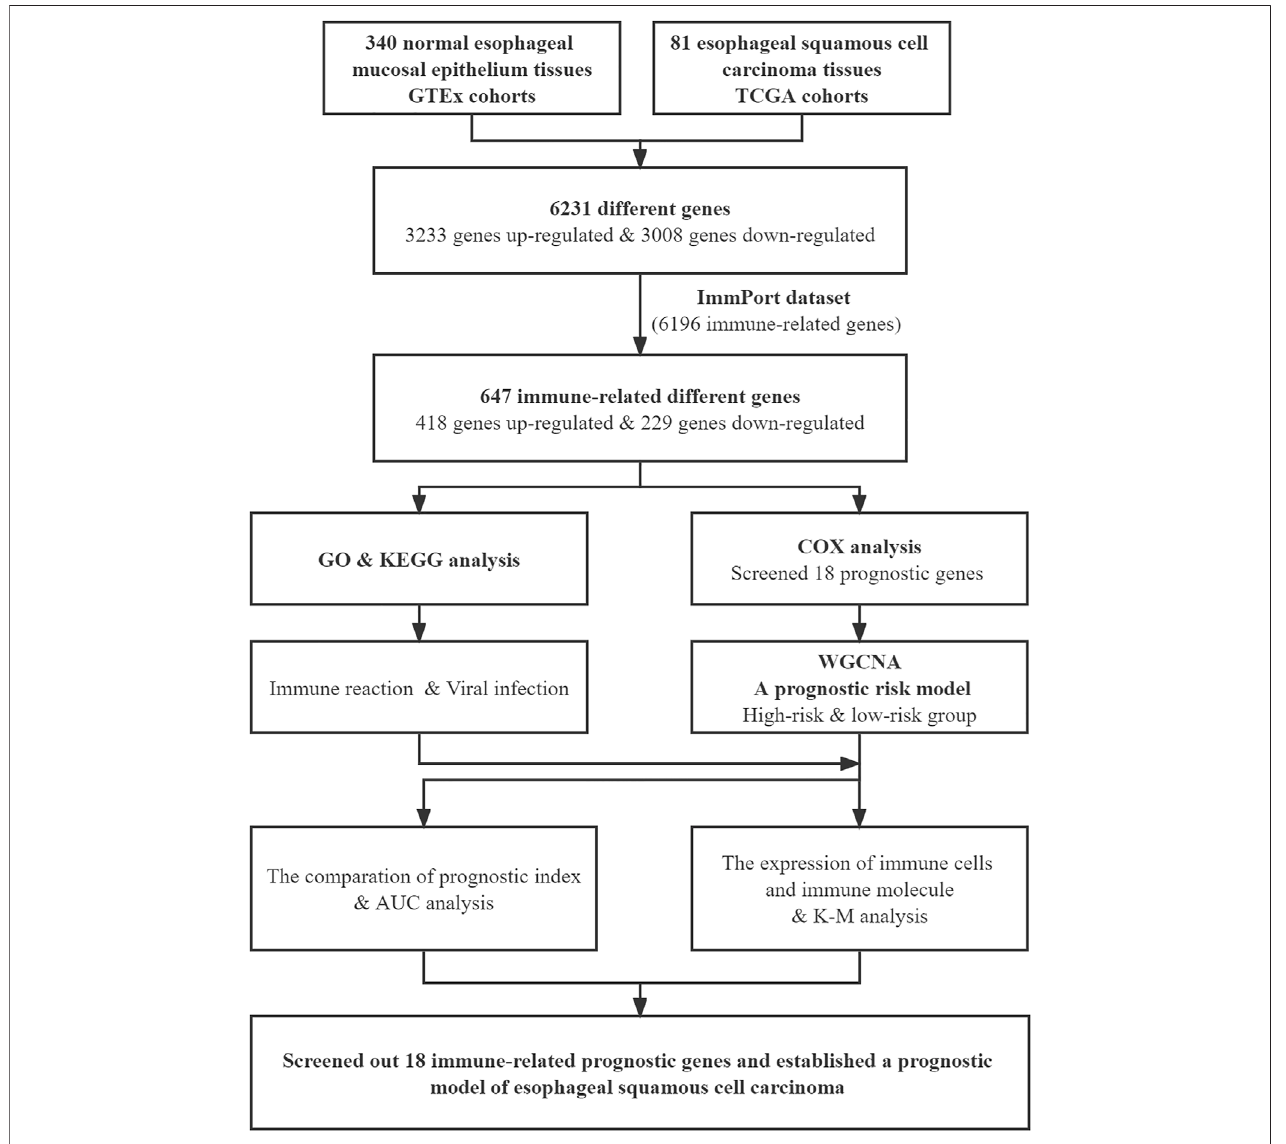
FIGURE 1 | Flow chart of this